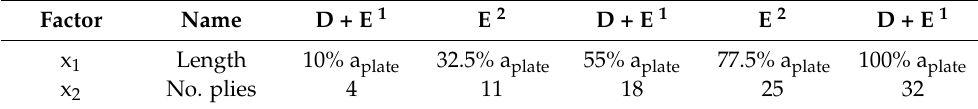
Table 3. Lack-of-fit test points.